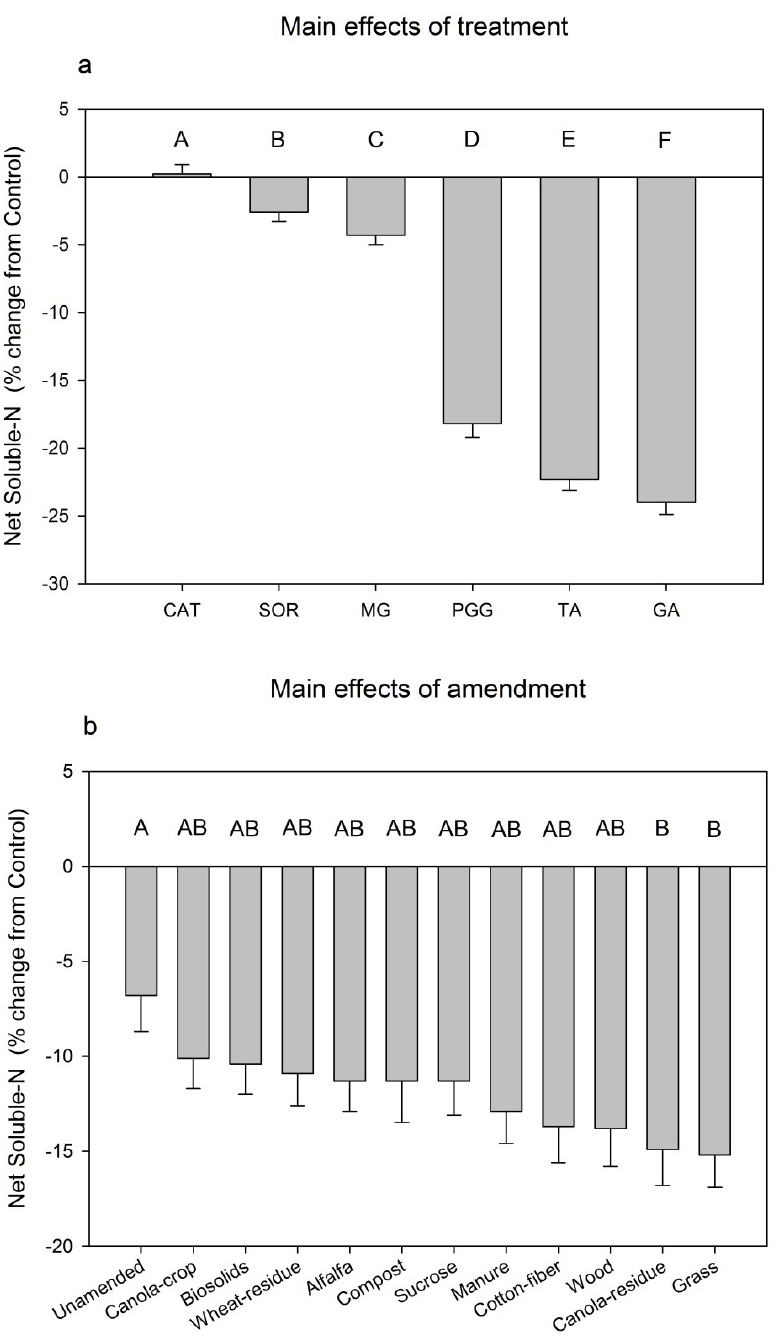
Figure 4. Average (SEM) effects of ( a ) phenolic treatment and ( b ) soil amendment on extraction of soluble-N. Differences among mean values are denoted by letters (n = 8, Tukey’s